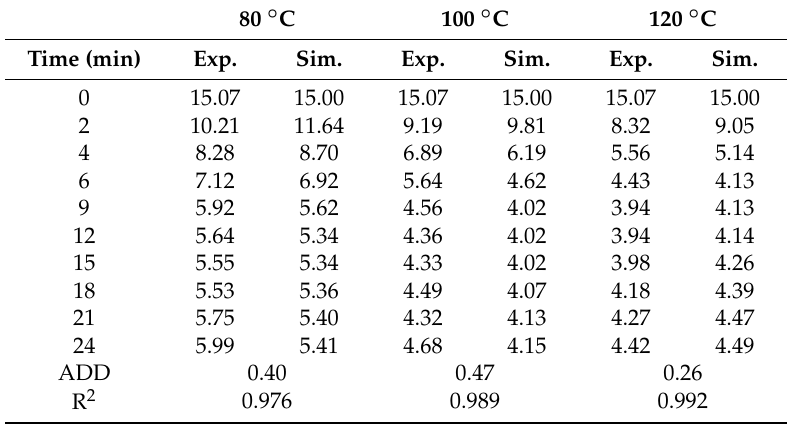
Table A1. The experimental and simulated MC, absolute average deviation (AAD) and coefficient of determination (R 2 ) for different set